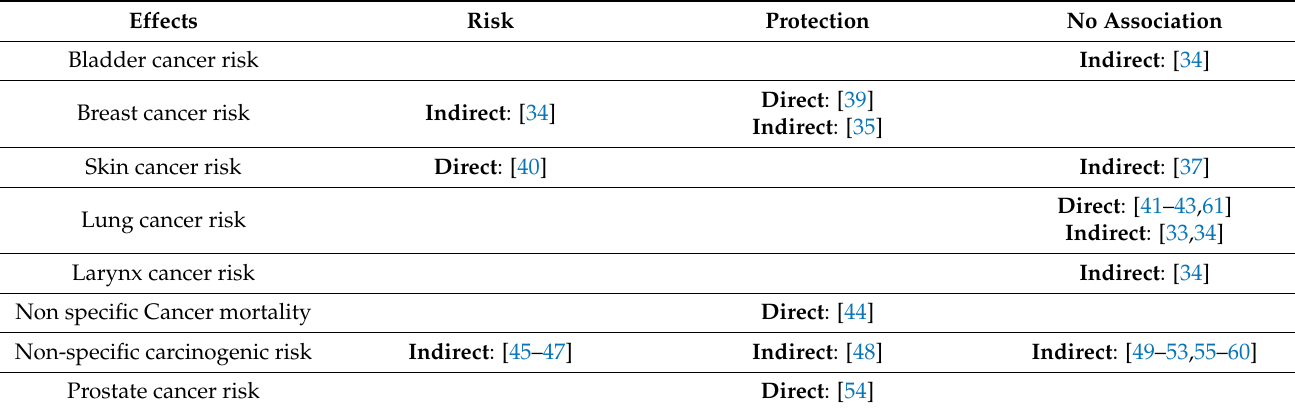
Table 2. The effects with direction observed in the included studies on cancer outcomes. The link was considered to be direct when the investigation of the relationship between green space and cancer was stated as an objective of the study, an outcome measure of cancer rate was used, the design and the statistical analysis were suitable to establish a relationship. In other cases or where it was not clearly described, the evidence was considered to be